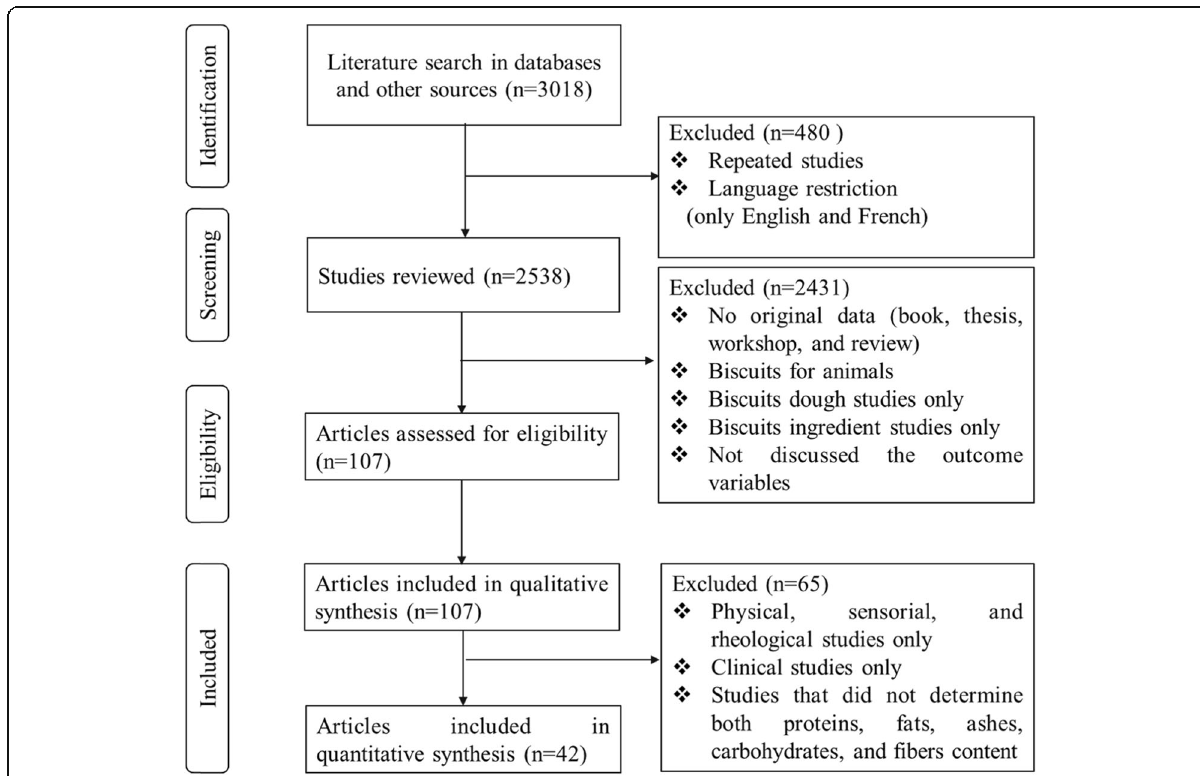
Fig. 1 Flow chart of screening